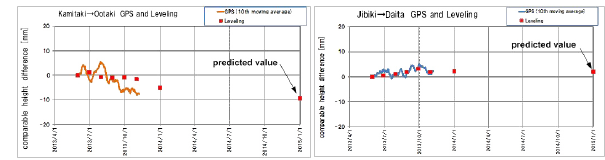
Figure 7. Comparable height difference Leveling (predicted